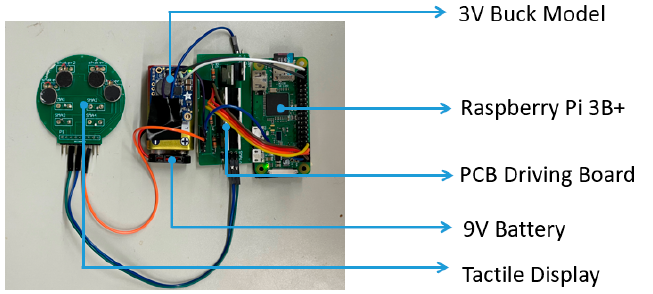
Figure 3. The tactile presentation device.